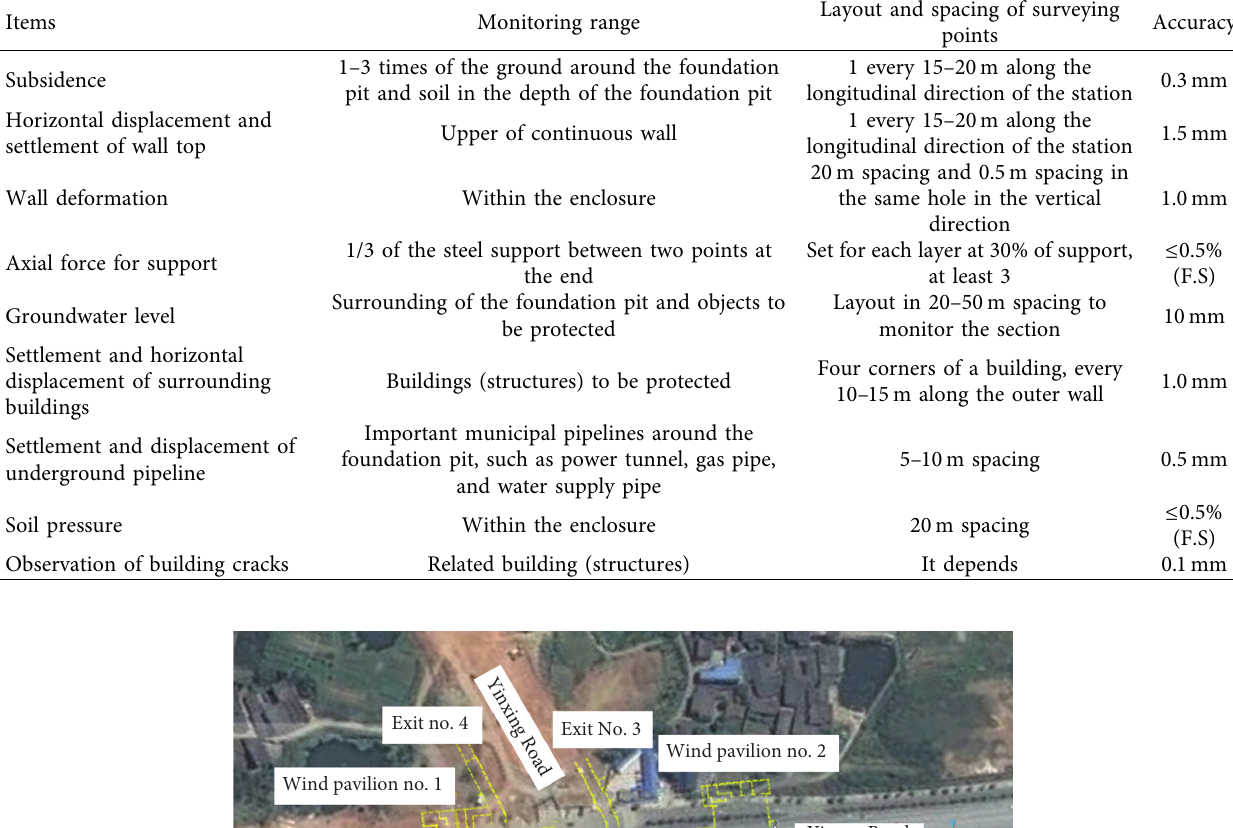
Table 2: Layout of surveying points for monitoring project.